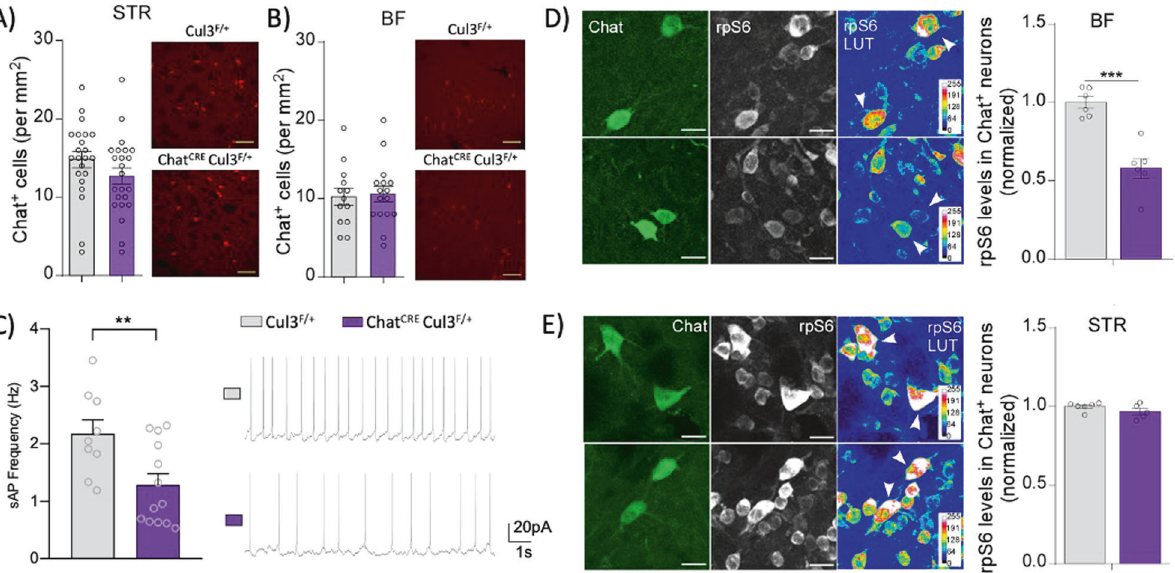
Fig. 3 Reduced activity of BF cholinergic neurons by Cul3 ablation. A , B Unchanged numbers of cholinergic neurons in both STR and BF of Chat CRE Cul3 F/ + mice (STR: n = 22 slices/6 Cul3 F/ + mice, n = 23 slices/6 Chat CRE Cul3 F/ + mice, t(43) = 1.43, p = 0.16; BF: n = 13 slices/4 Cul3 F/ + mice, n = 16 slices/4 Chat CRE Cul3 F/ + mice, t(27) = 0.22, p = 0.83, unpaired two-tailed t-test). C Plot of synaptic-driven, spontaneous action potential (sAP) frequencies showing the signi fi cant reduction in BF cholinergic neurons of Chat CRE Cul3 F/ + mice ( n = 9 cells/3 Cul3 F/ + mice, n = 13 cells/4 Chat CRE Cul3 F/ + mice, t(20) = 2.85, p = 0.0098, unpaired two-tailed t-test). Inset: Representative sAP traces. D , E Representative confocal images and quanti fi cation of rpS6-S240/S244 in ChAT + cholinergic neurons in the BF ( D ) or the STR ( E ) ( D , n = 70 cells/6 Cul3 F/ + mice, n = 67 cells/6 Chat CRE Cul3 F/ + mice, t(10) = 5.69, p = 0.002; E , n = 68 cells/6 Cul3 F/ + mice, n = 54 cells/5 Chat CRE Cul3 F/ + mice, t(9) = 1.42, p = 0.19, unpaired two-tailed t-test). In all fi gures, ** p < 0.01, *** p <